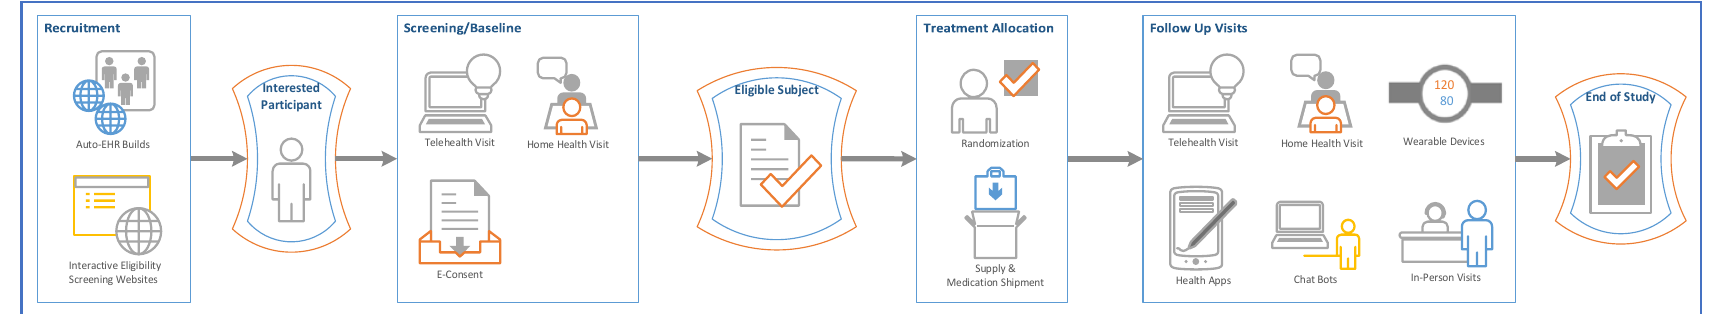
Figure 2. Various digital health technologies can be incorporated to streamline trials; automatic electronic health record (EHR) builds can identify patients, interactive websites can allow patients to enter information directly and if they meet certain criteria can be directed to a chat bot or scheduled for a telehealth visit automatically. Home health visits can be used to collect information that requires additional support/procedures (samples for lab tests, physical exams, administration of medications (i.e., via IV or injection)). Health apps can be used for collecting patient-reported outcomes, adverse events (AEs), concomitant medications, other surveys, and for delivering medication education and dose adjustment information. Reporting of AEs can also be done via a chat bot with an automatic trigger to schedule a telehealth visit if certain criteria are met. Wearable devices can be used to collect vital signs, EKGs, sleep quality, etc. Onsite visits can be included as needed for safety concerns. Some portion of subjects are still expected to be lost to follow up; however DH, technologies may decrease this number.